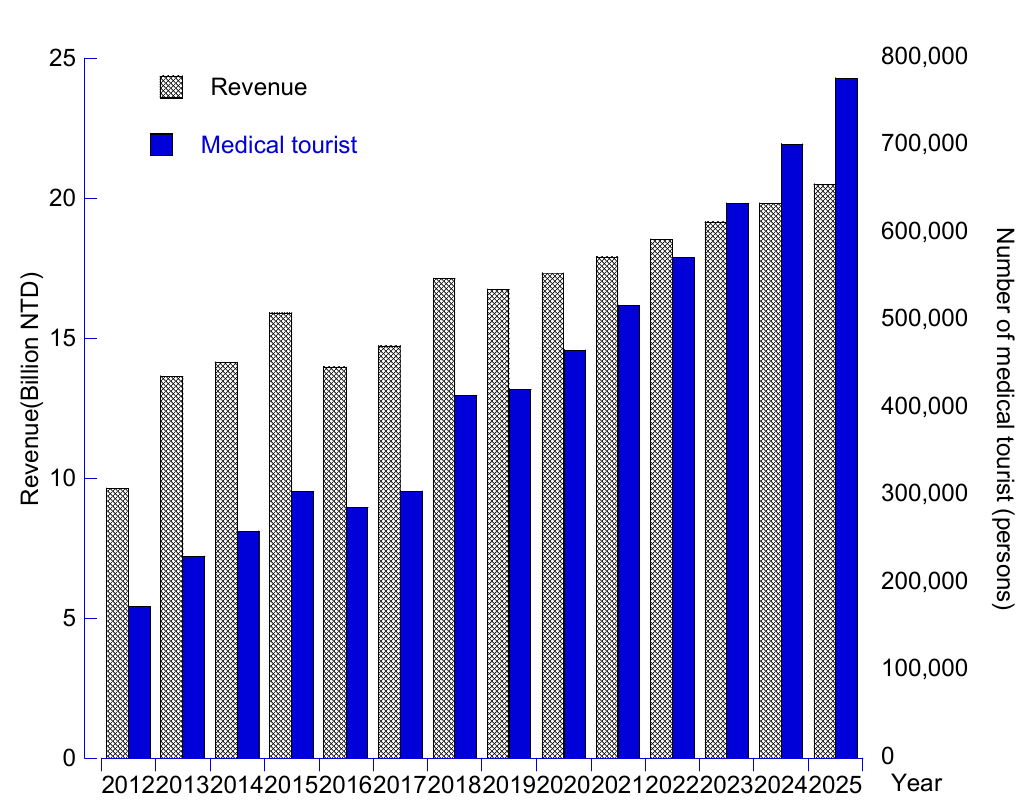
Figure 7. The market size of Taiwan’s medical tourism industry over the next six years.